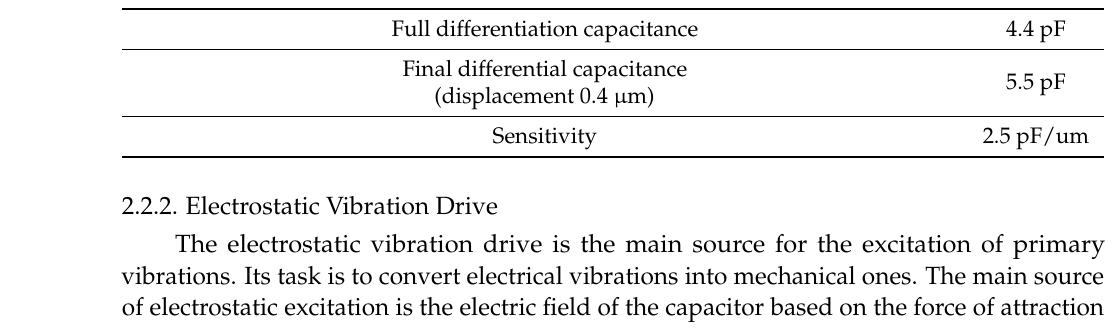
Table 2. Parameters of the differential capacitance of the SE.